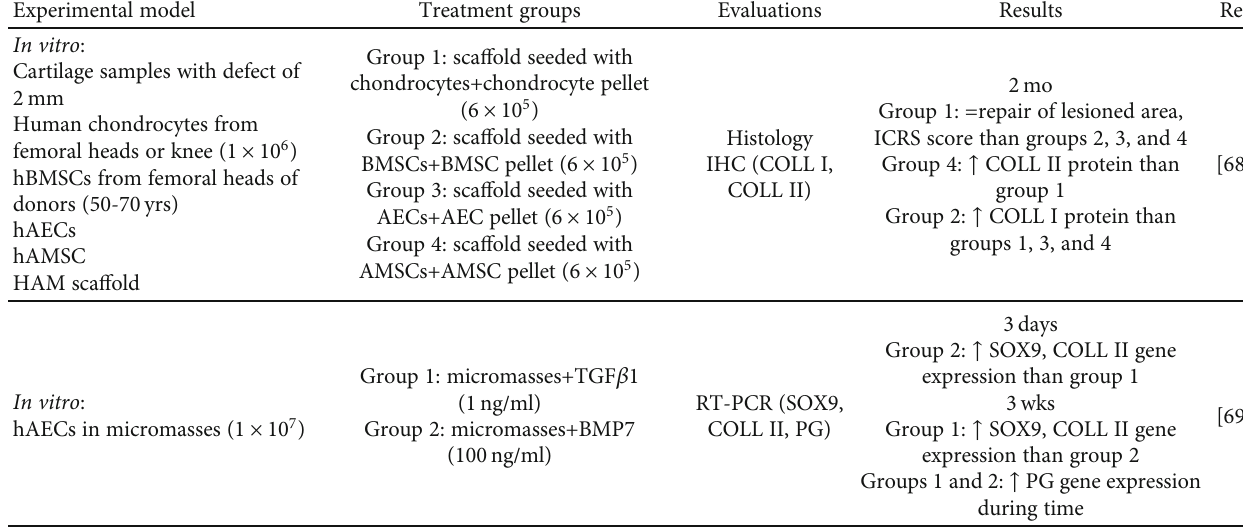
Table 5: In vitro , in vivo , and clinical studies on AECs in cartilage